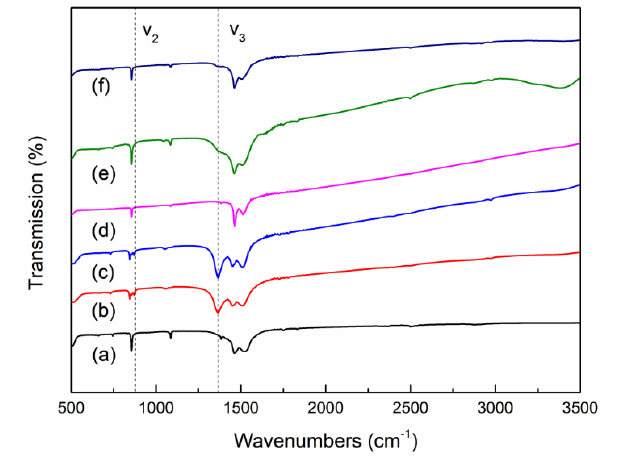
Figure 2. FT-IR spectra of ( a ) PL-6h, ( b ) PL-12h, ( c ) PL-24h, ( d ) HL-6h, ( e ) HL-12h, and ( f ) HL-24h.